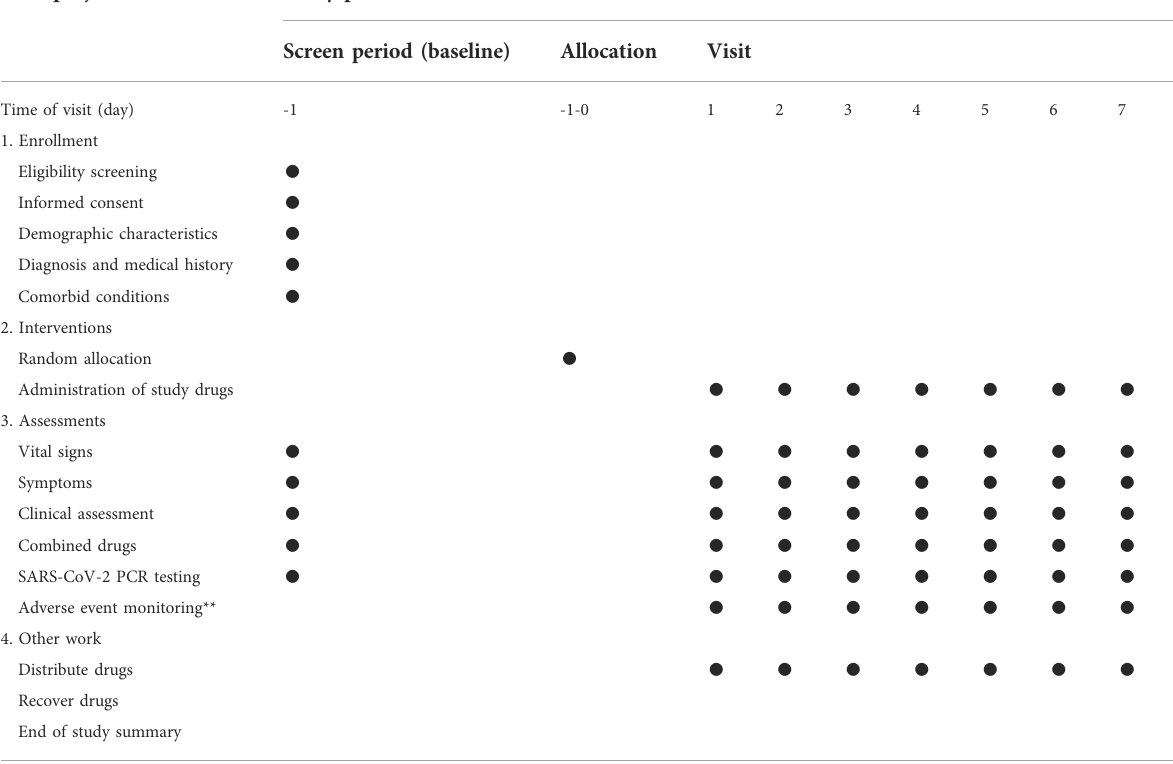
TABLE 1 SPIRIT Schedule of enrollment, interventions and